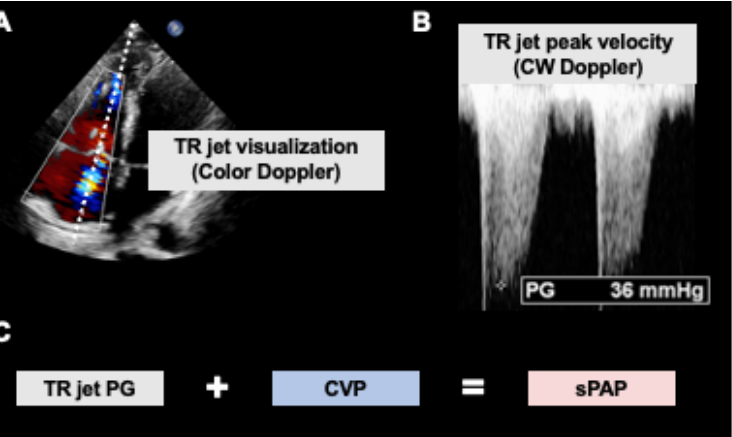
Figure 4. Noninvasive estimation of systolic pulmonary artery pressures using echocardiography .